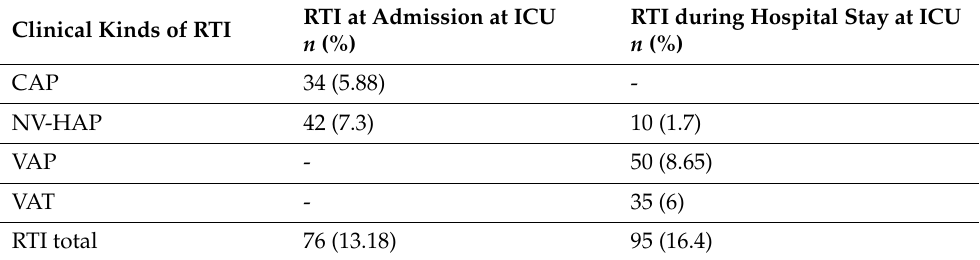
Table 2. Frequency of respiratory tract infections during a study period. Data are presented as number of infections and percentage from the total number of hospitalized patients ( n =